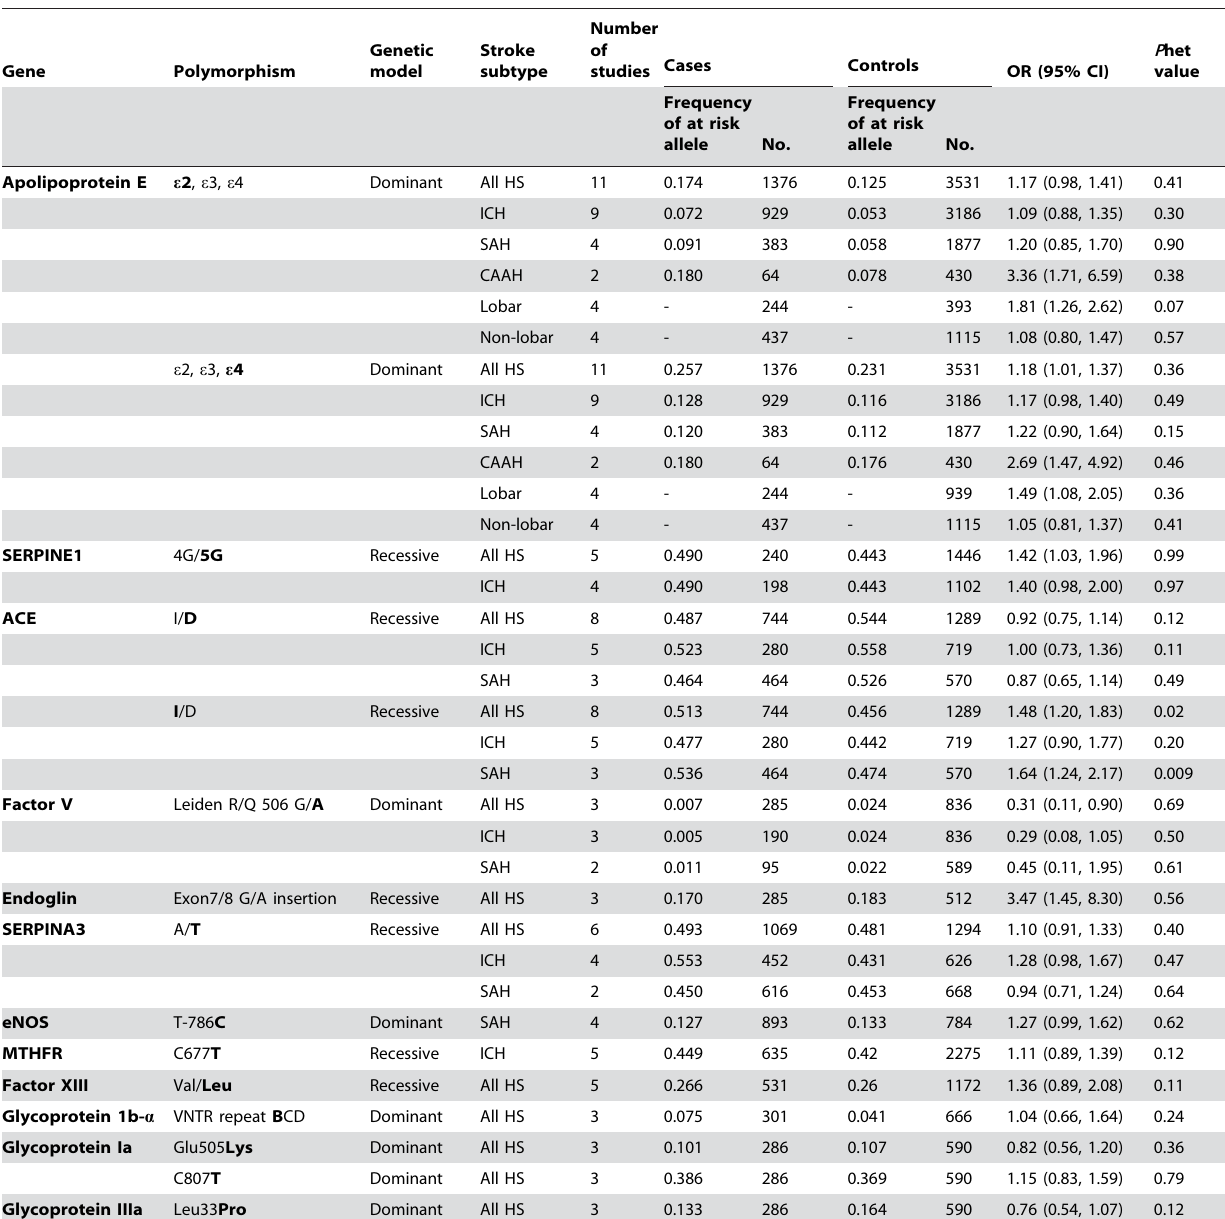
Table 2. Summary data of candidate genes in haemorrhagic